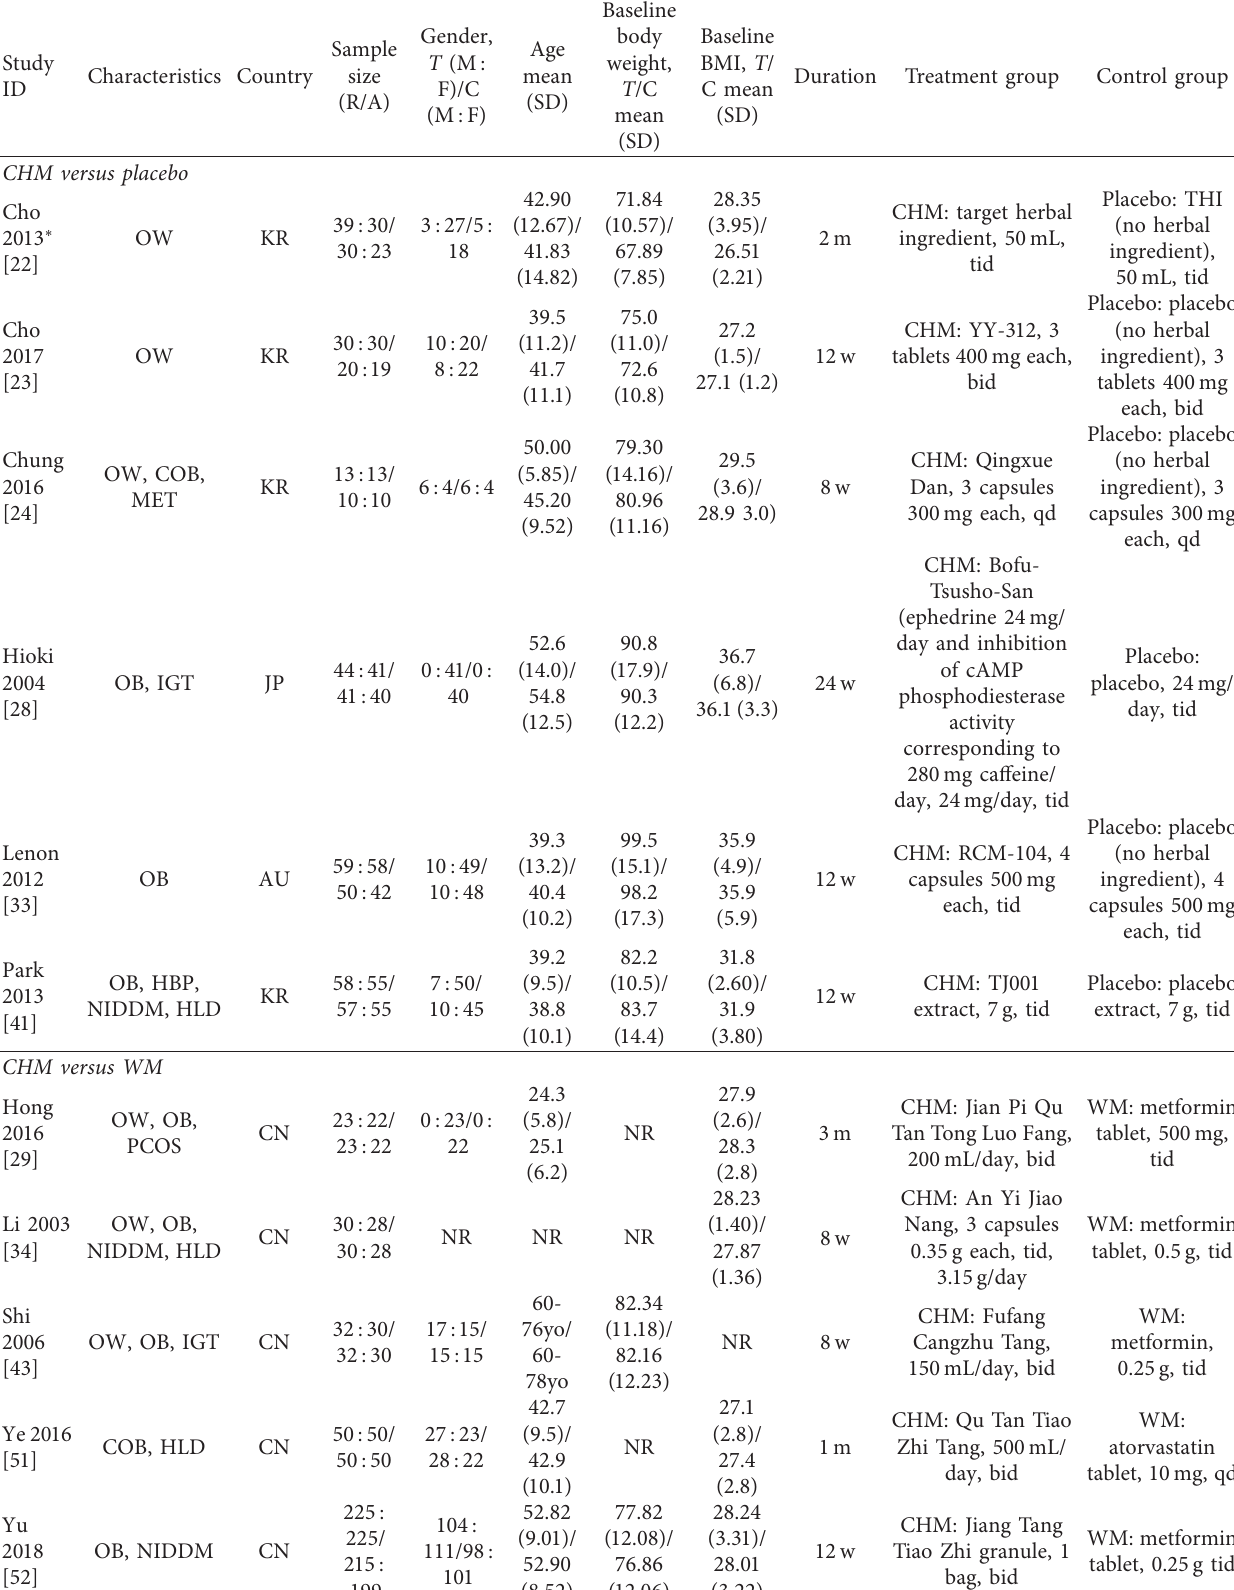
Table 1: Characteristics of 39 included